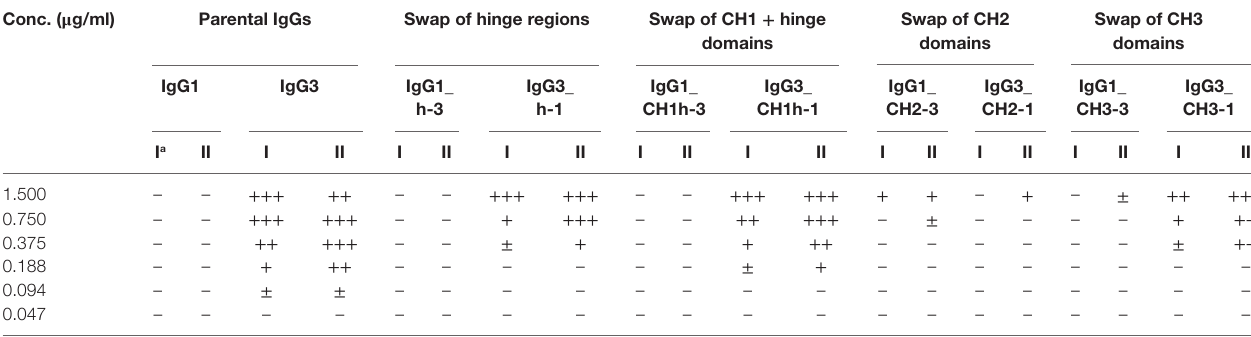
a Results of two independent experiments designated as I and II.